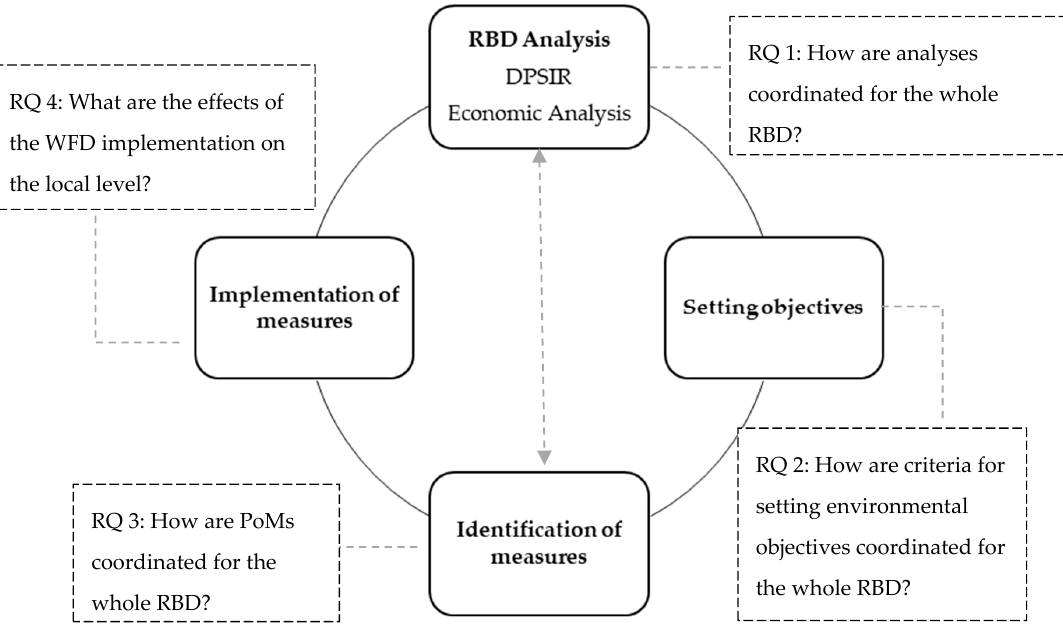
Figure 1. Four key-tasks for the Water Framework Directive (WFD) implementation and related research questions. Source: Authors’ own elaboration .